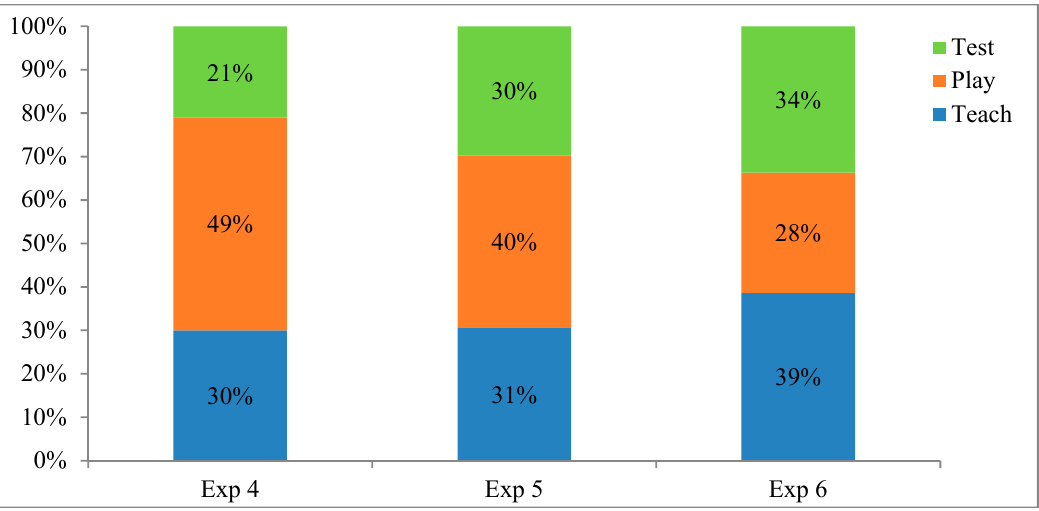
Figure 6 . Percentage of teach, play, and test sections by experiment for CYCLES Carnivale . Note: values do not add up to 100% because of rounding error.